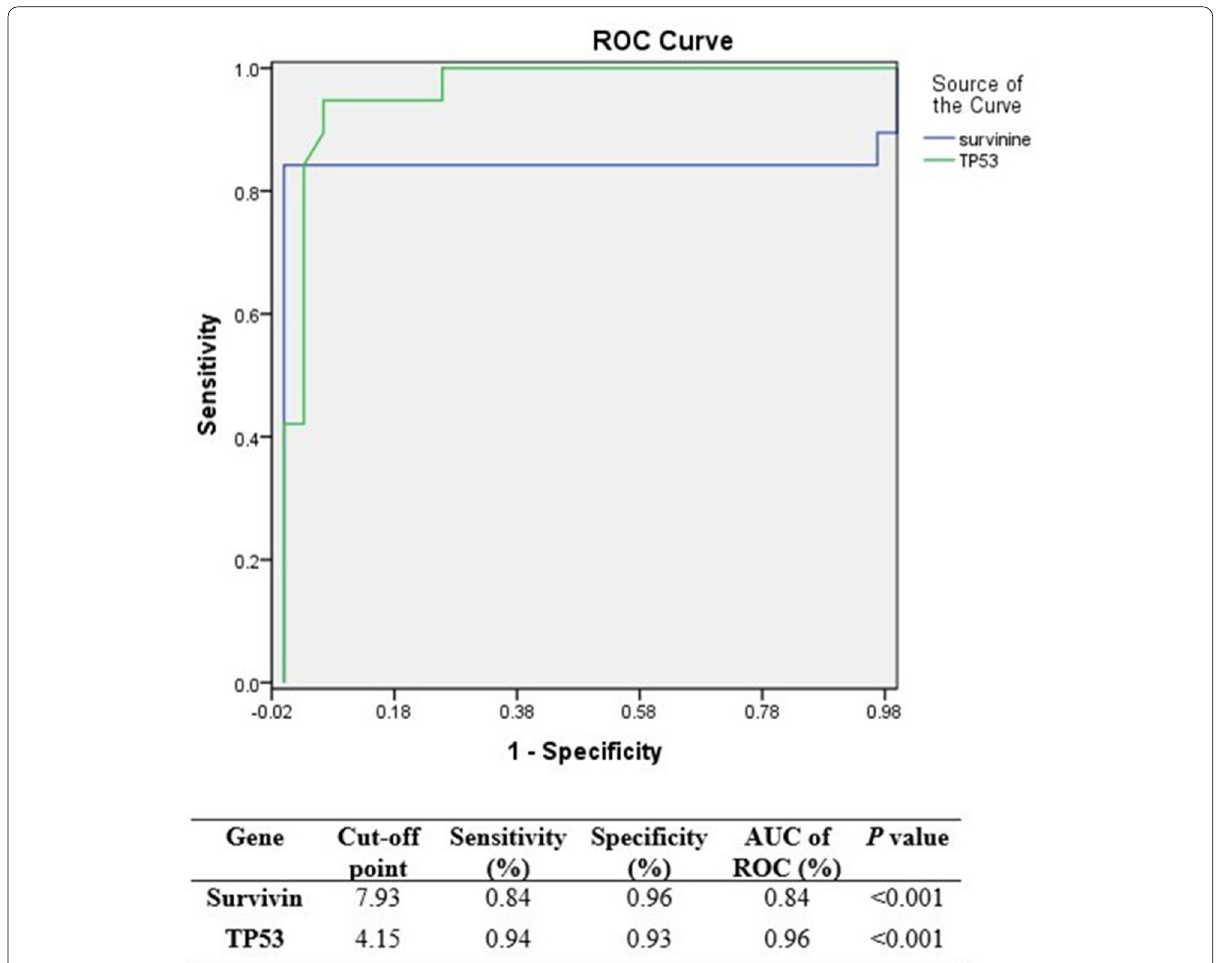
Fig. 2 Receiver operating characteristic (ROC) curves were performed to determine the area under the ROC curve (AUC), sensitivity, specificity, and p ‑value to determine the levels of the survivin and TP53 that best differentiate the UTUC versus the UBC. The optimal cutoff values were calculated as the marker level that maximizes the sensitivity and